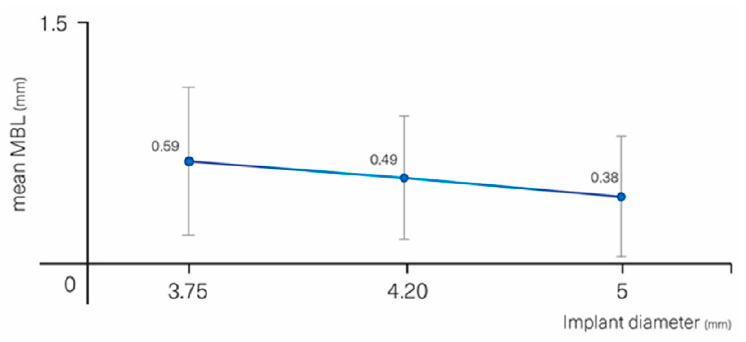
Figure 6. MBL vs. implant diameter. Table 4. Association between MBL and other clinical parameters: Wald chi [2] test results of the general linear regression model.